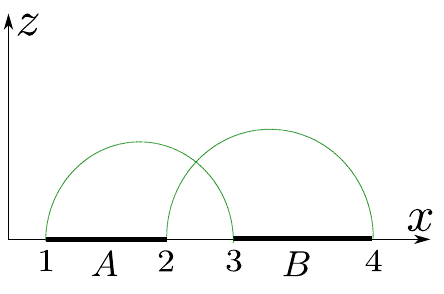
Figure 17 . An unphysical con(cid:12)guration for S ( A [ B